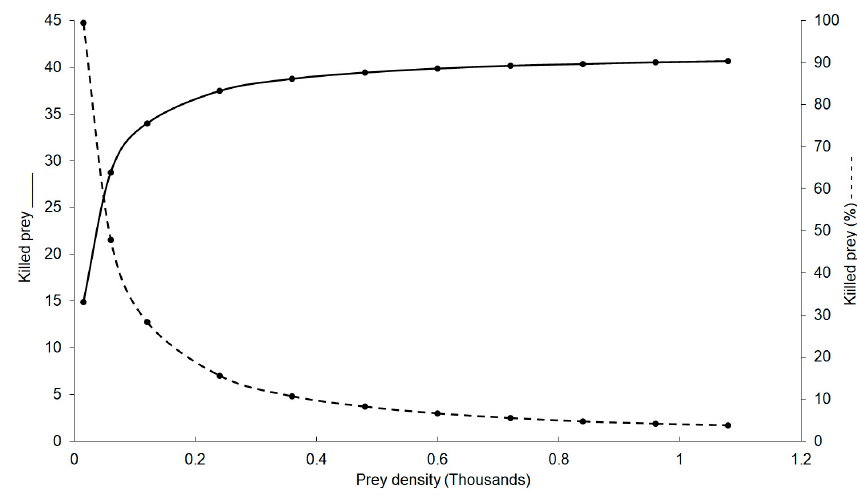
Figure 2. Functional response curve fit by non-linear least-squares regression of Pseudoophonus rufipes adults attacking Ceratitis capitata pupae exposed in the laboratory, acting alone (type II). Host density: 5, 20 or 40 larvae per adult (three) and day.